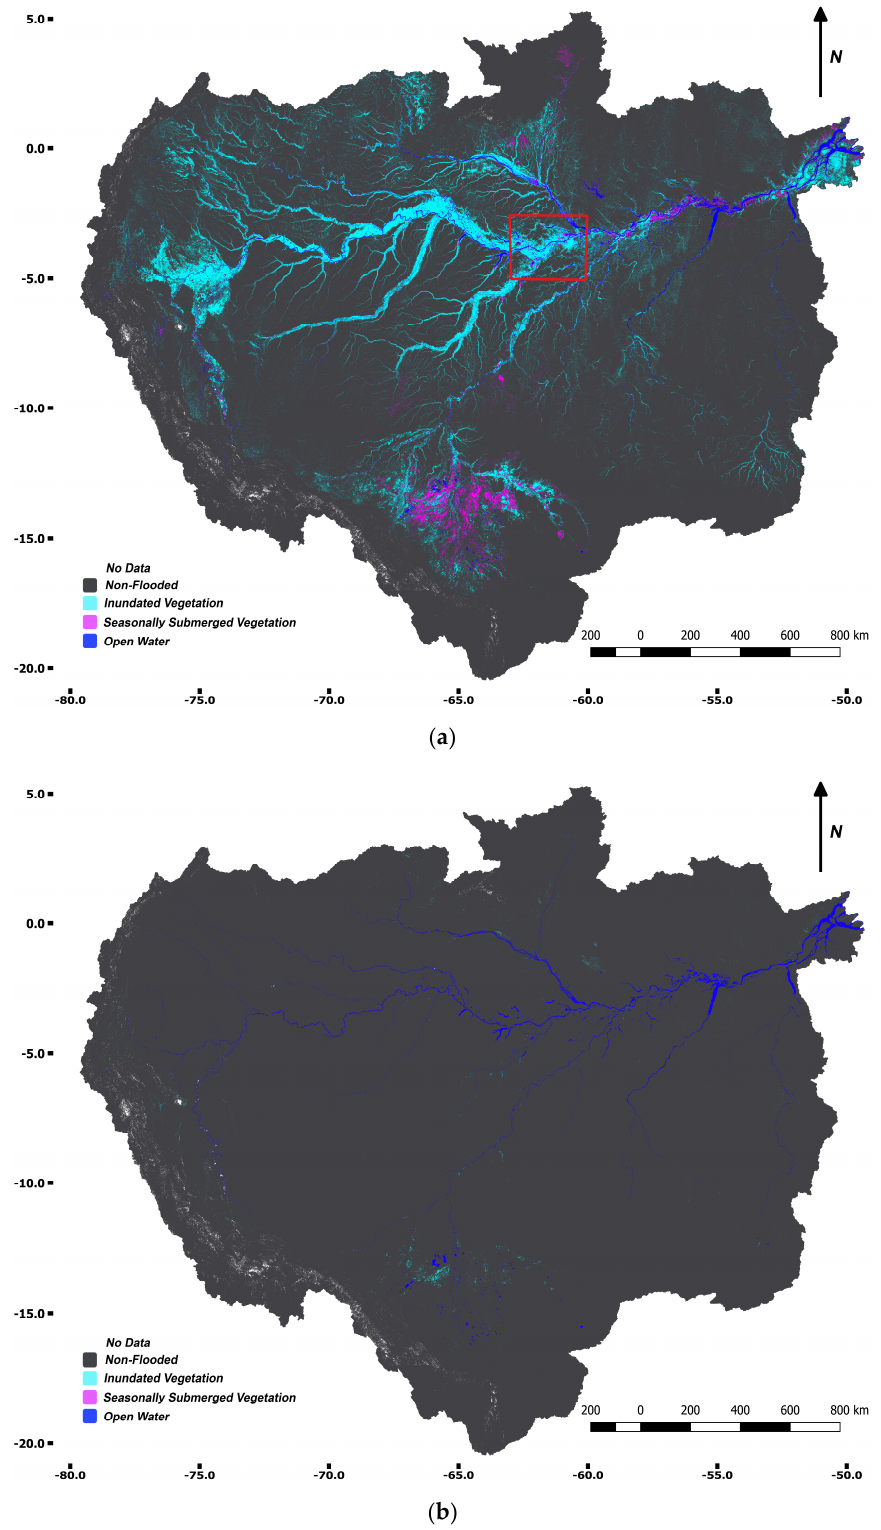
Figure 6. ( a ) Full-basin maximum inundation extent for 2014 / 2015. Light blue: inundated vegetation; purple: submerged vegetation; blue: open water; grey: non-flooded; white: no data. The red box indicates the region shown in Figure 7. ( b ) Full basin minimum inundation extent classification for the hydrological year 2015 / 2016. Light blue: inundated vegetation; purple: submerged vegetation; blue: open water; grey: non-flooded; white: no